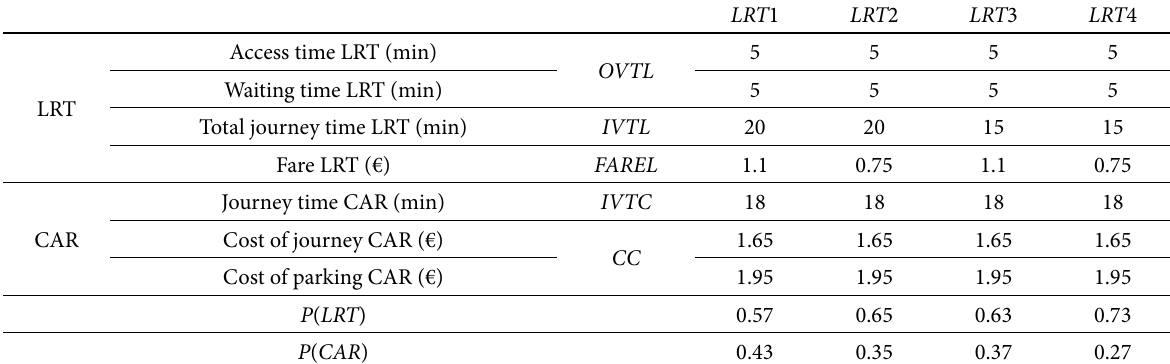
Table 12. LRT vs. Car